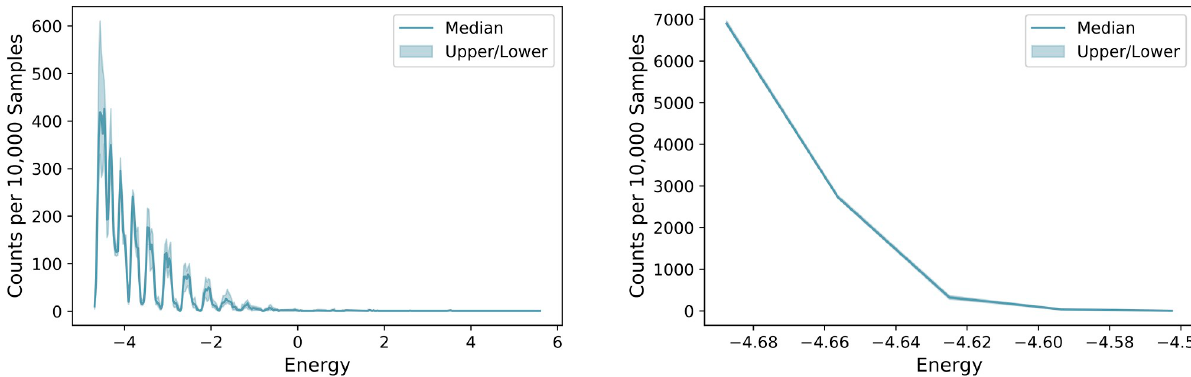
Fig 10. Number of results returned for each energy. Left: using quantum annealing, Right: using simulated annealing.